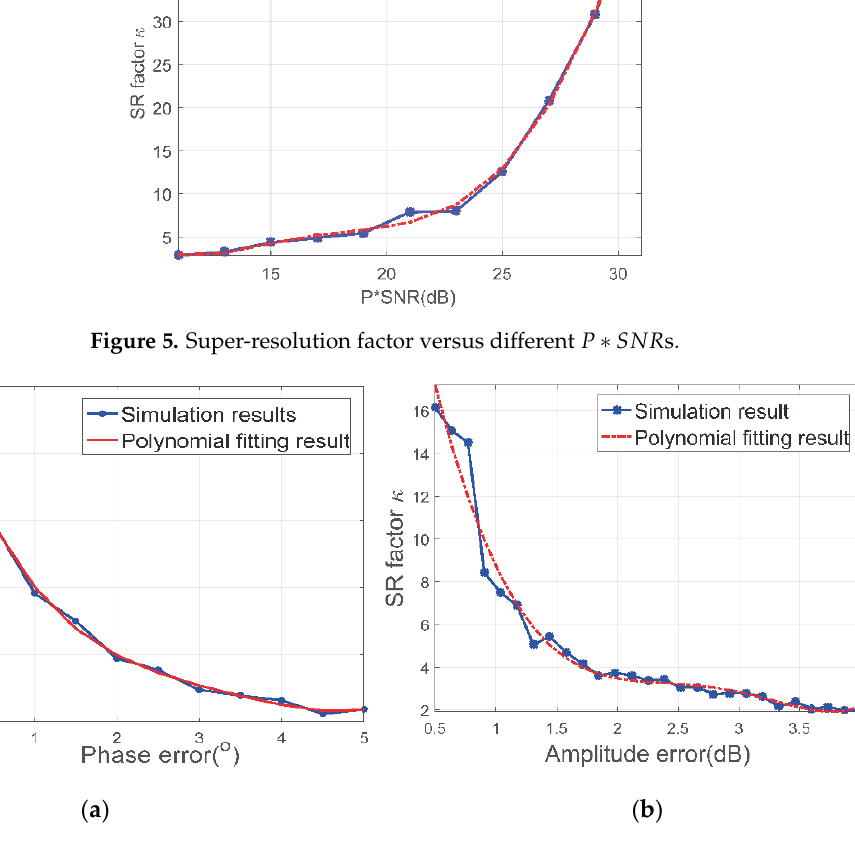
Figure 6. Super-resolution factor versus different kind of error ( a ) SR factor with respect to different phase error; ( b ) SR factor with respect to different amplitude error.